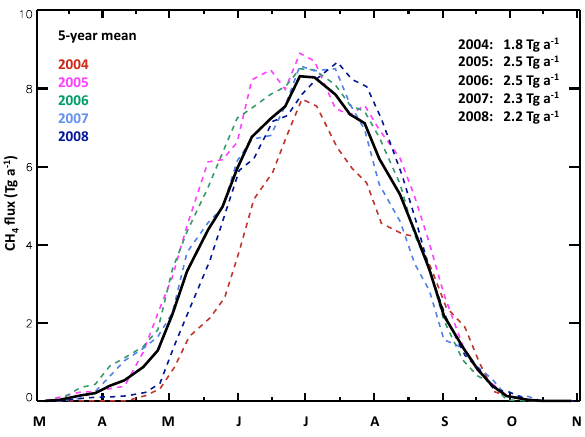
Fig. 5. Seasonal variation of HBL methane emissions simulated by the model for 2004–2008. Values are integrated spatially over the HBL domain (50 ◦ N–60 ◦ N, 75 ◦ W–96 ◦ W) and smoothed tem- porally with a 4-week moving average. Also tabulated are annual emission estimates for individual